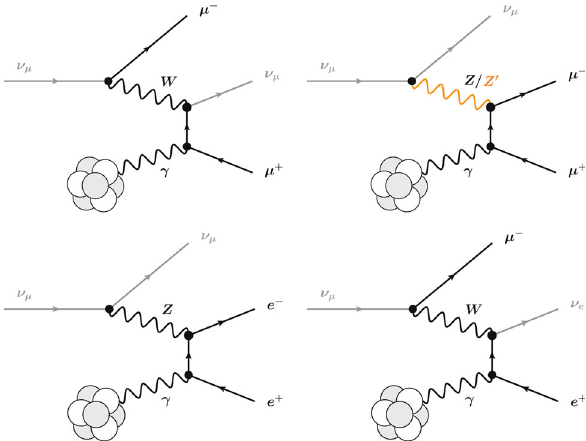
Fig. 13 Atmospheric fluxes of neutrinos and antineutrinos as a func- tion of energy for conventional oscillations (dashed line) and in the Fig. 14 Example diagrams for muon-neutrino-induced trident pro- non-minimal isotropic Standard Model Extension (solid line) cesses in the Standard Model. A second set of diagrams where the photon couples to the negatively charged leptons is not shown. Analo- gous diagrams exist for processes induced by different neutrino flavors and by antineutrinos. A diagram illustrating trident interactions medi- conventional oscillations with standard three-flavor oscilla- ated by a new Z (cid:5) gauge boson, discussed in the text, is shown on the tion parameter values from the PDG [135], the fluxes at the top right FD are shown in Fig. 13. The sum of the ν e and ¯ ν e fluxes is shown as a function of energy as a red dashed line, while Table 6 Expected number of SM ν μ and ¯ ν μ -induced trident events at the sum of the ν μ and ¯ ν μ fluxes is shown as a blue dashed the LArTPC of the DUNE ND per metric ton of argon and year of line. Adding an isotropic non-minimal coefficient for Lorentz operation ( 6 ) = 1 × 10 − 28 GeV − 1 changes the violation of magnitude ˚ c e μ fluxes from the dashed lines to the solid ones. This coefficient is many times smaller than the current experimental limit.